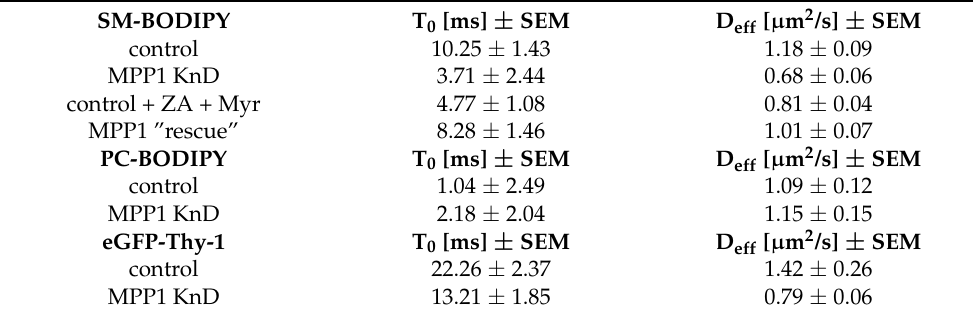
Table 1. Summary of the diffusion parameters assessed by